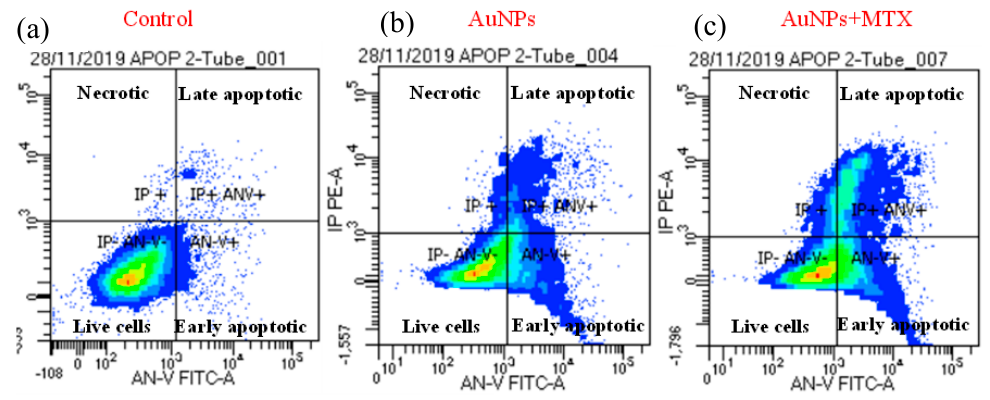
Figure 10. Flow cytometric analysis to determine death modes of cancer cells to HTC-116. The percentage of necrotic and apoptotic HTC-116 cells ( a ) Control ( b ) AuNPs and ( c ) AuNP–MTX400. ( d ) Comparison of time response to equal doses of AuNPs and AuNP–MTX400. ( e ) Representative percentage of necrotic and apoptotic AuNPs and AuNP–MTX400. 3. Materials and Methods 3.1. Reagents Chloroauric acid (HAuCl 4 ), trisodium citrate dehydrate (Na 3 C 6 H 5 O 7 ), methotrexate (C 20 H 22 N 8 O 5 ) and sodium hydrogen carbonate (NaHCO 3 ) were of analytical grade and used without further purification (Sigma-Aldrich, St. Louis, MO, USA). All solutions were made using double distilled Milli-Q water (18 M Ω ). 3.2. Synthesis of Gold Nanoparticles (AuNPs) Reference gold nanoparticles were synthesized based on the methods described in detail elsewhere [12,39]. Briefly, 1 mL of chloroauric acid dissolution (25 mM) was added to 150 mL of a boiling sodium citrate solution (TCS) (2.2 mM) under vigorous stirring and kept in the dark for